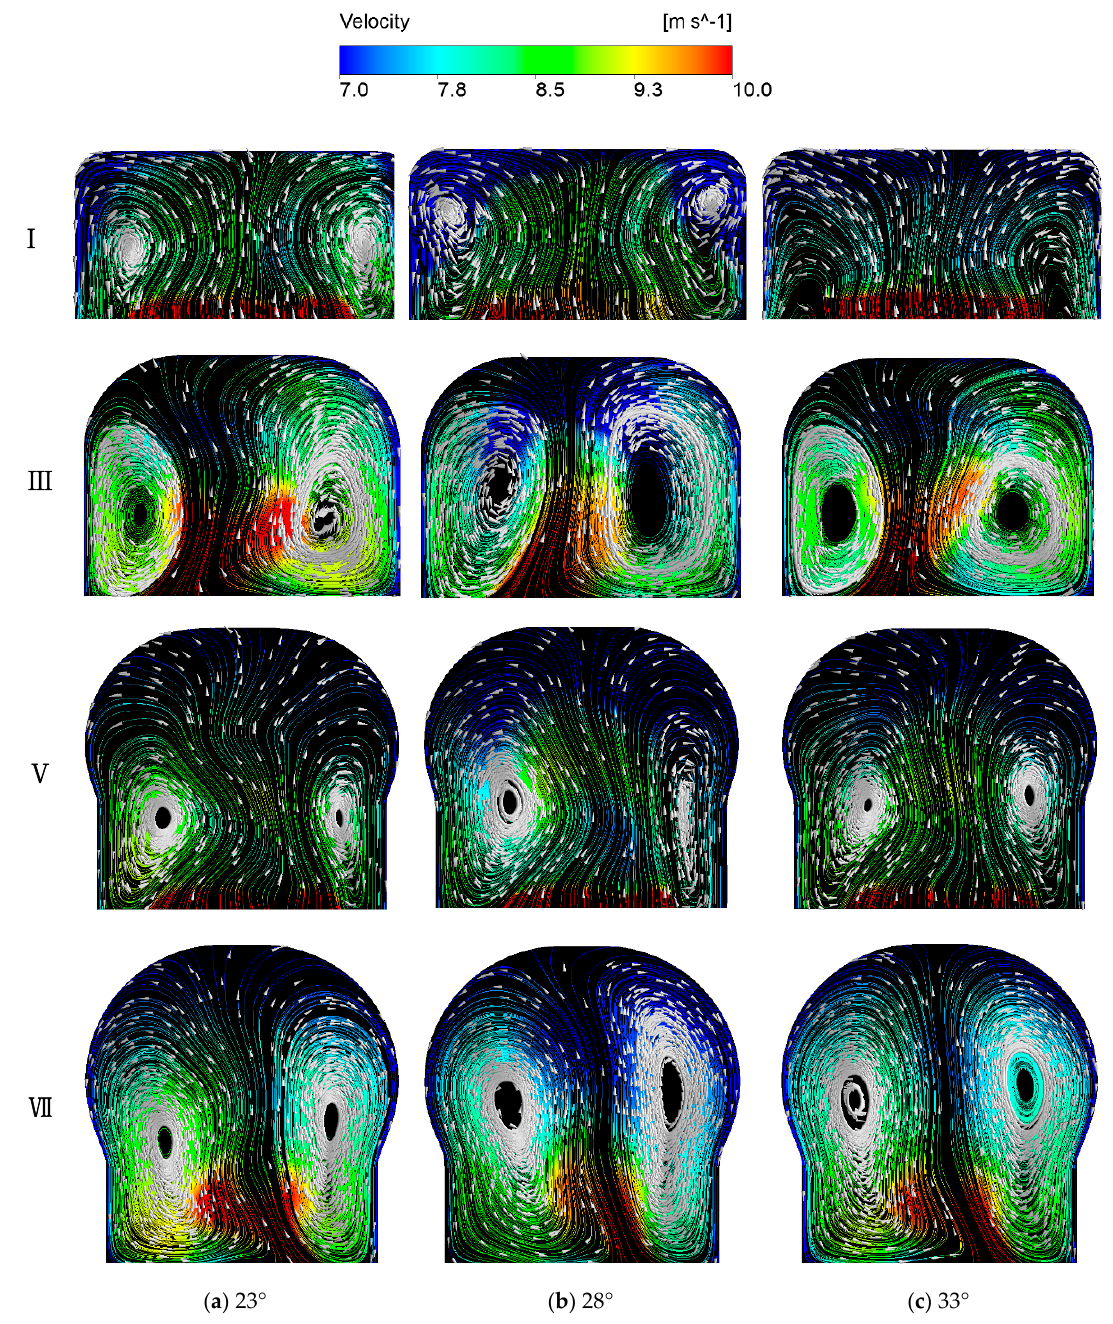
Figure 17. Vector distribution of four radial cross sections under design flow rate condition.